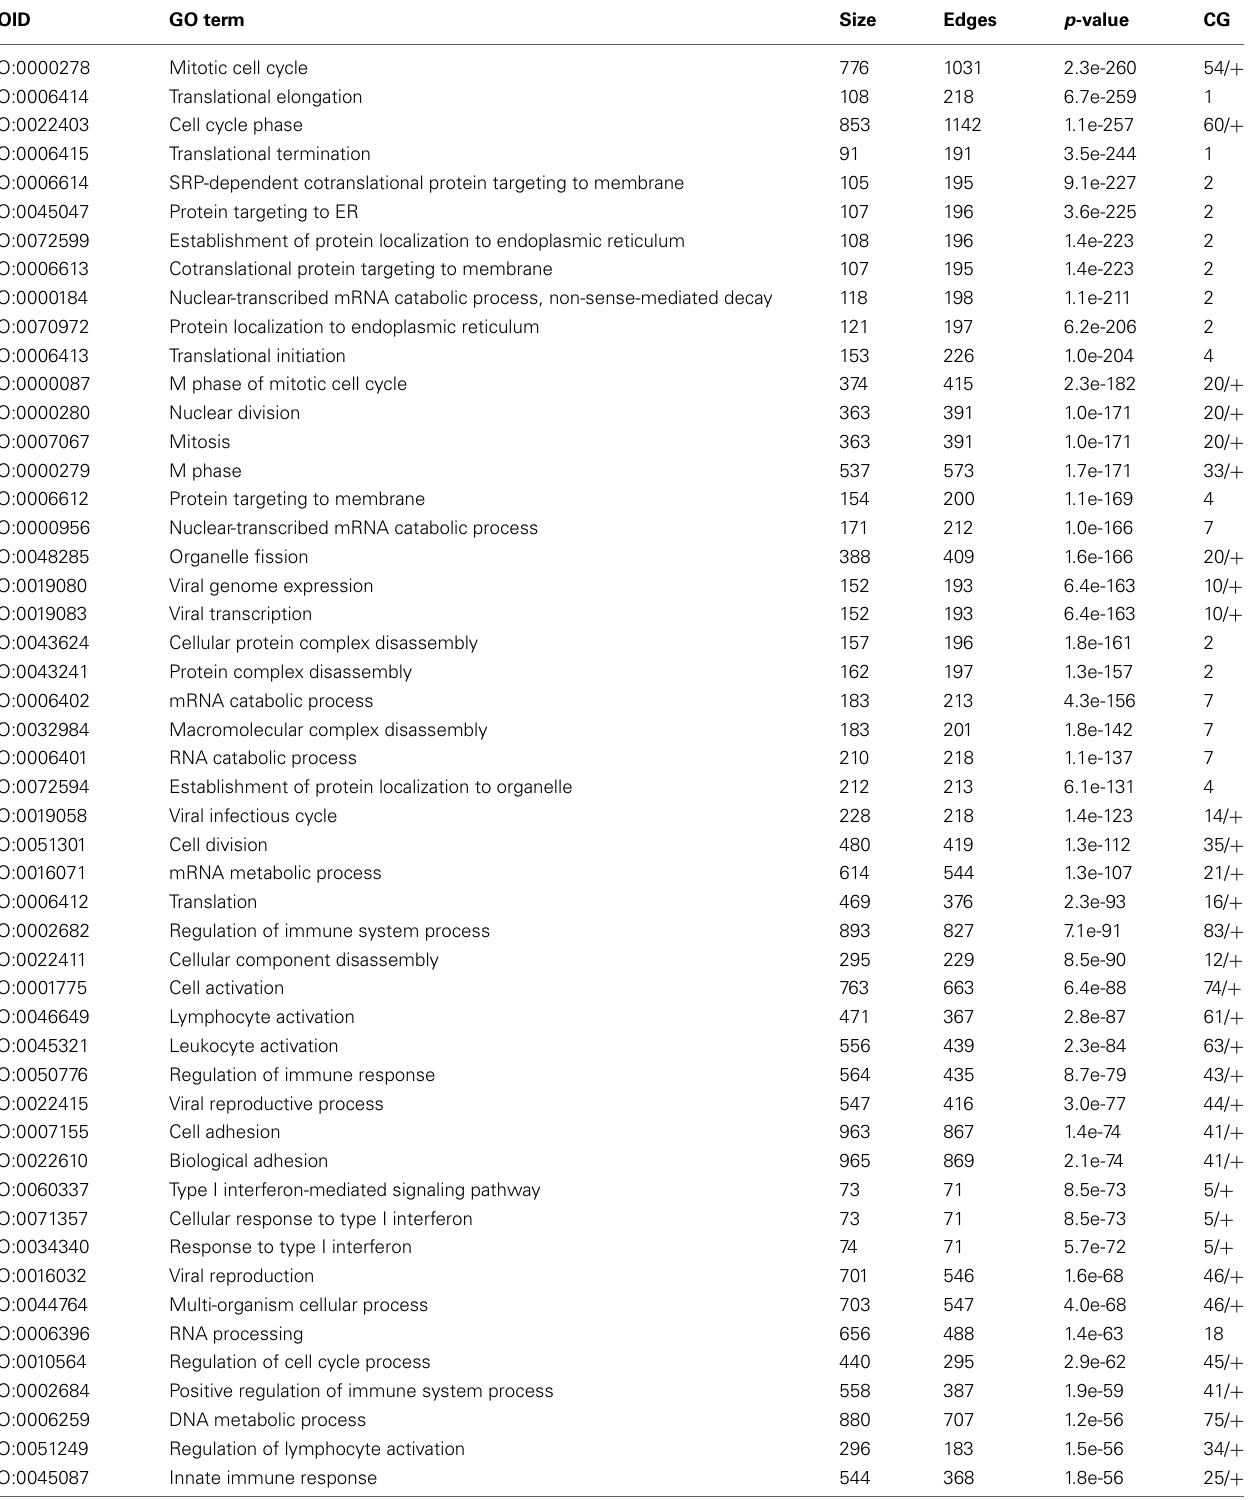
Table 2 | GPEA analysis of the breast cancer gene regulatory network for GO biological